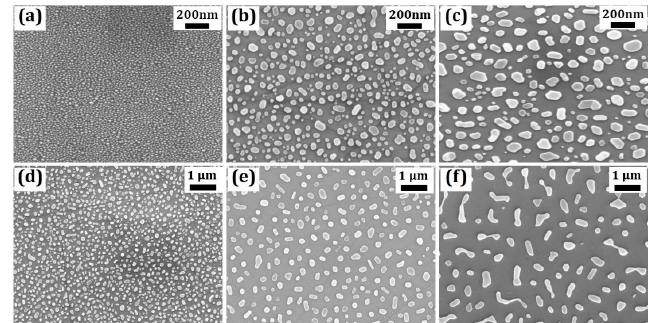
Figure 2. Top-view SEM image of Au nanoparticles formed by rapid thermal process (RTP) of samples with varied deposited Au film thicknesses: ( a ) 3 nm, ( b ) 5 nm, ( c ) 7 nm, ( d ) 9 nm, ( e ) 11 nm and ( f ) 13 nm, respectively.